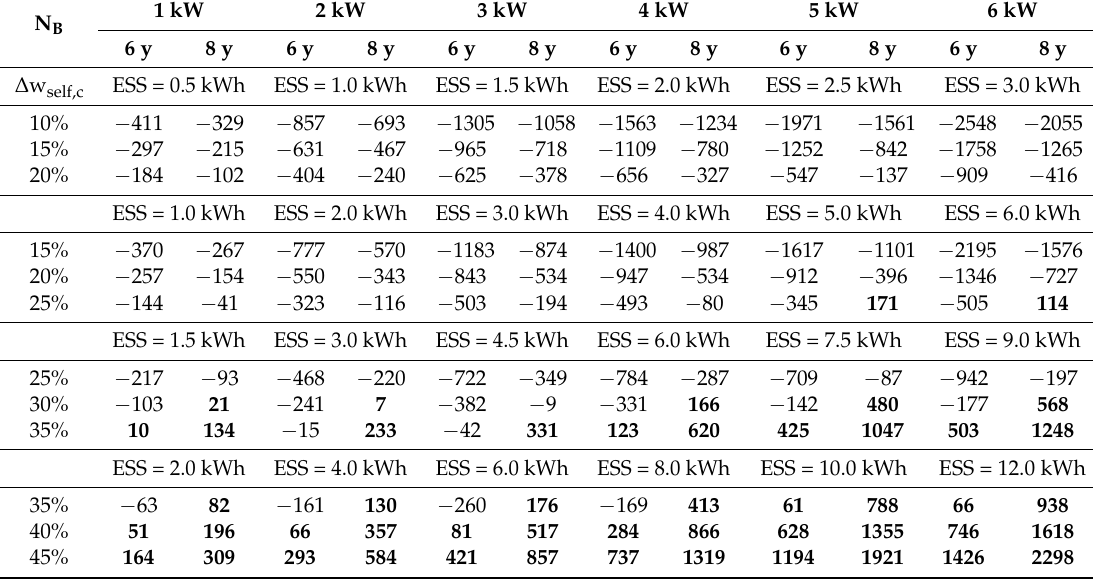
Table 3. Net Present Value ( € ) of